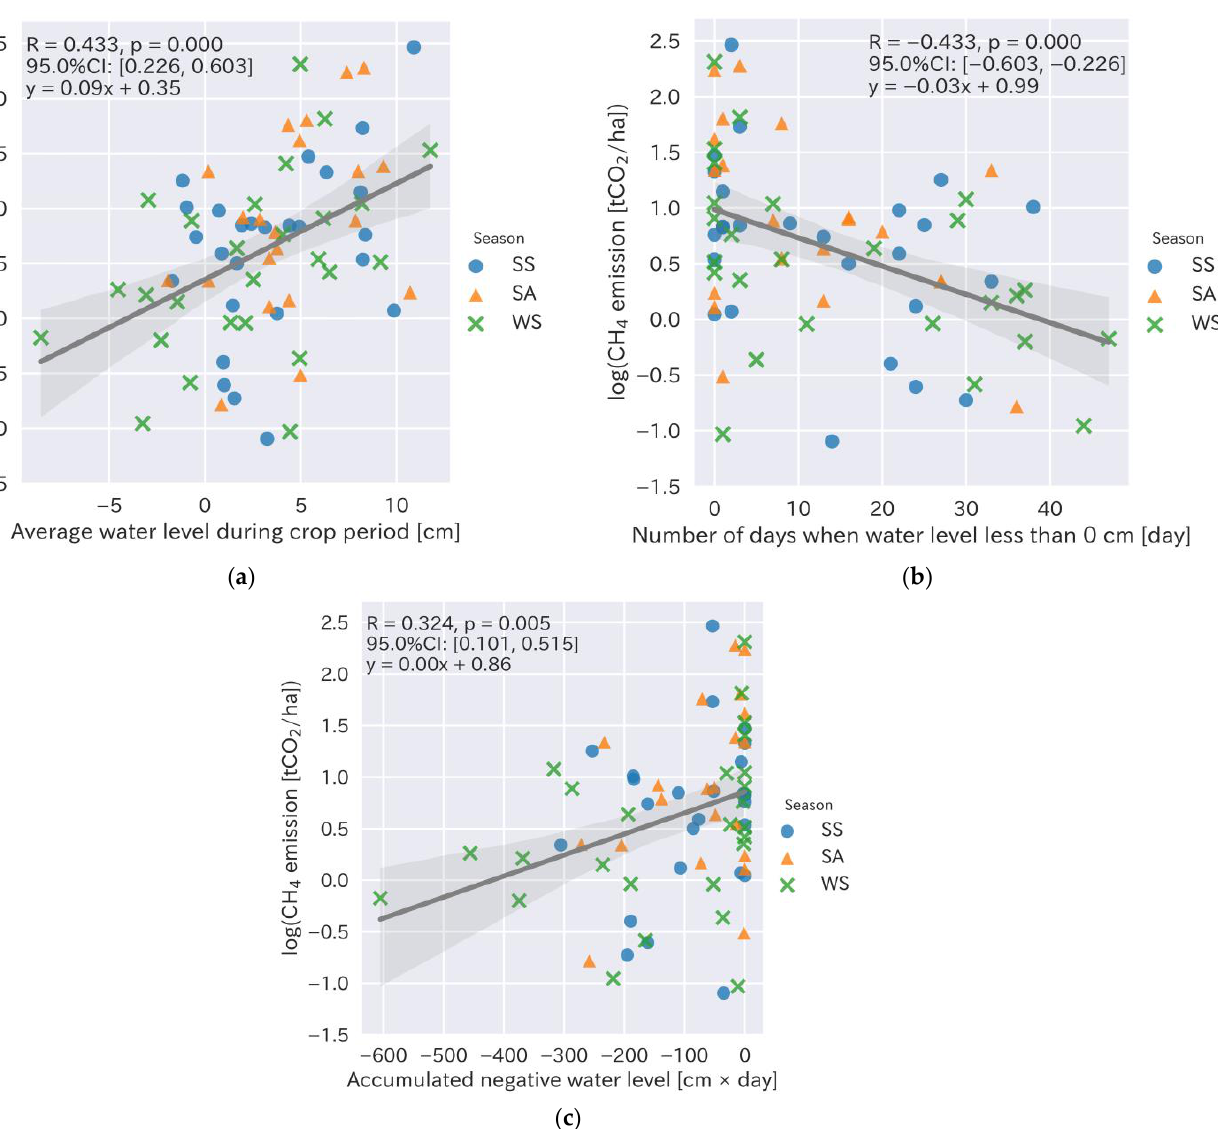
Figure 5. Relationship between methane emissions and specific water management practices during the cropping period and rice yield. ( a ) Average water level during the cropping period (cm); ( b ) days of negative water levels during the cropping period (days); ( c ) accumulated negative water level during the cropping period (mm). Circles, triangles, and crosses show data from the spring – summer (SS), summer – autumn (SA), and winter – spring (WS) seasons, respectively.